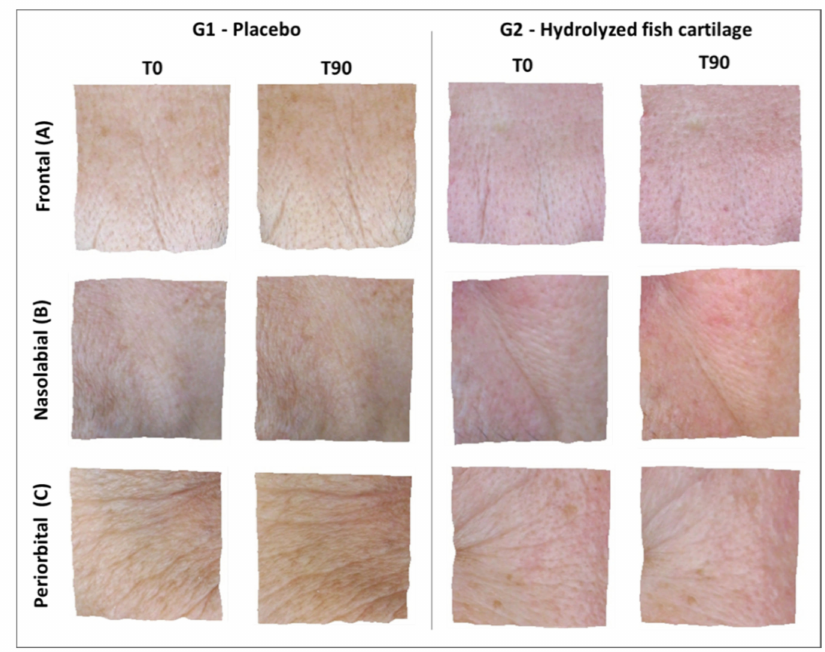
Figure 3. Representative 3D high-resolution images of wrinkles on the frontal ( A ), nasolabial ( B ), and periorbital ( C ) regions of the face before (T0) and after 90 days (T90) of supplementation with hydrolyzed fish cartilage or the placebo using the Visioface ® Quick software version 1.0.3.4.